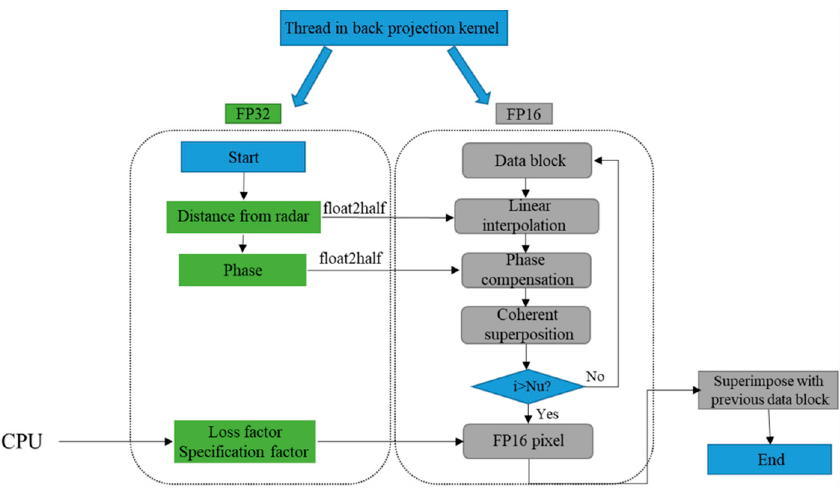
Figure 8. Mixed-precision back projection in a thread.